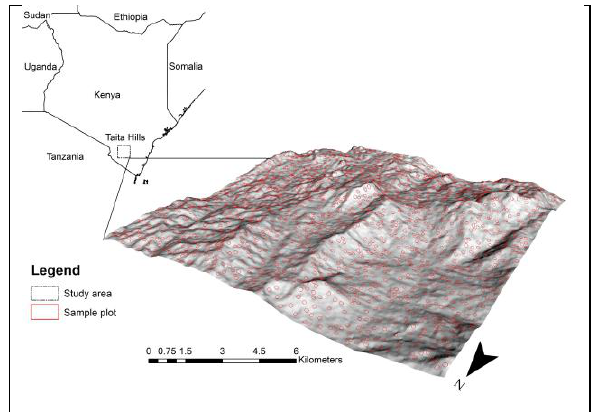
Figure 1. Location of the study area and hillshade view of the